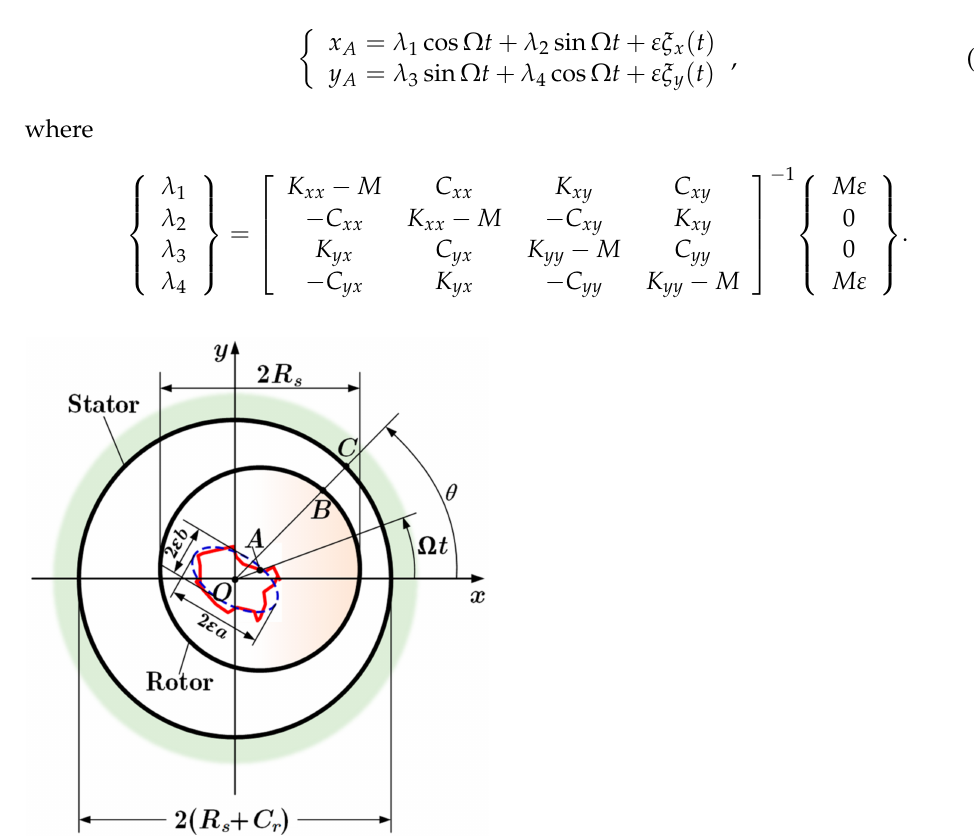
Figure 2. Randomly uncertain orbit of the rotor